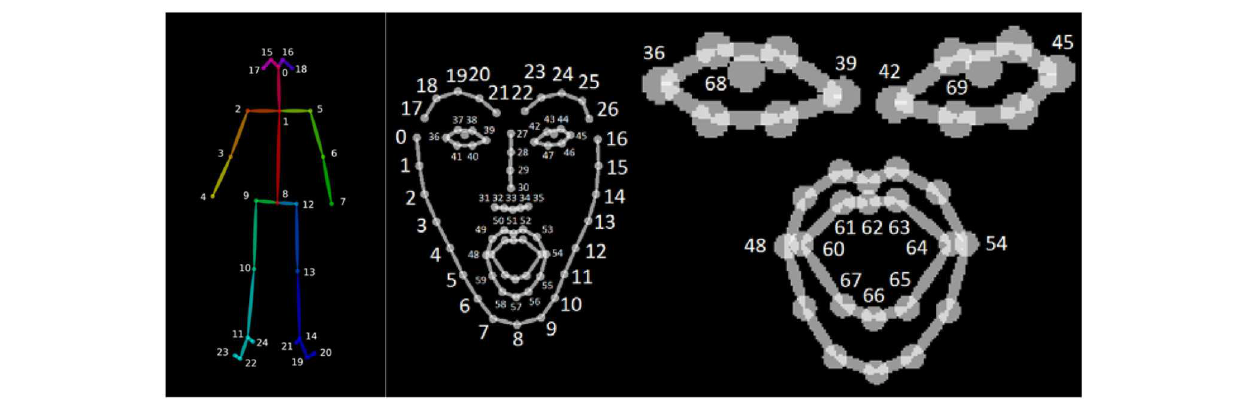
FIGURE 5 | Illustrations of the skeletal and facial keypoints extracted by OpenPose (CMU Perceptual-Computing-Lab, 2019) (permission acquired from the author for using these images with citation).